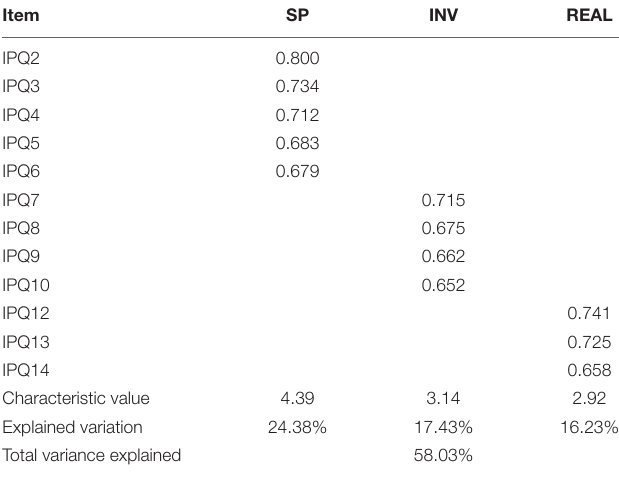
TABLE 1 | Factor analysis results of IPQ.